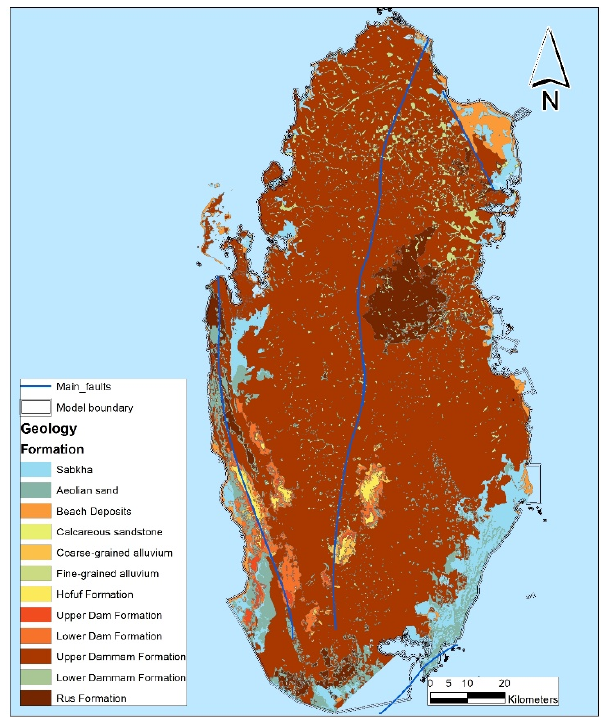
Figure 1. Simplified geological map of Qatar (from Baalousha [4]).